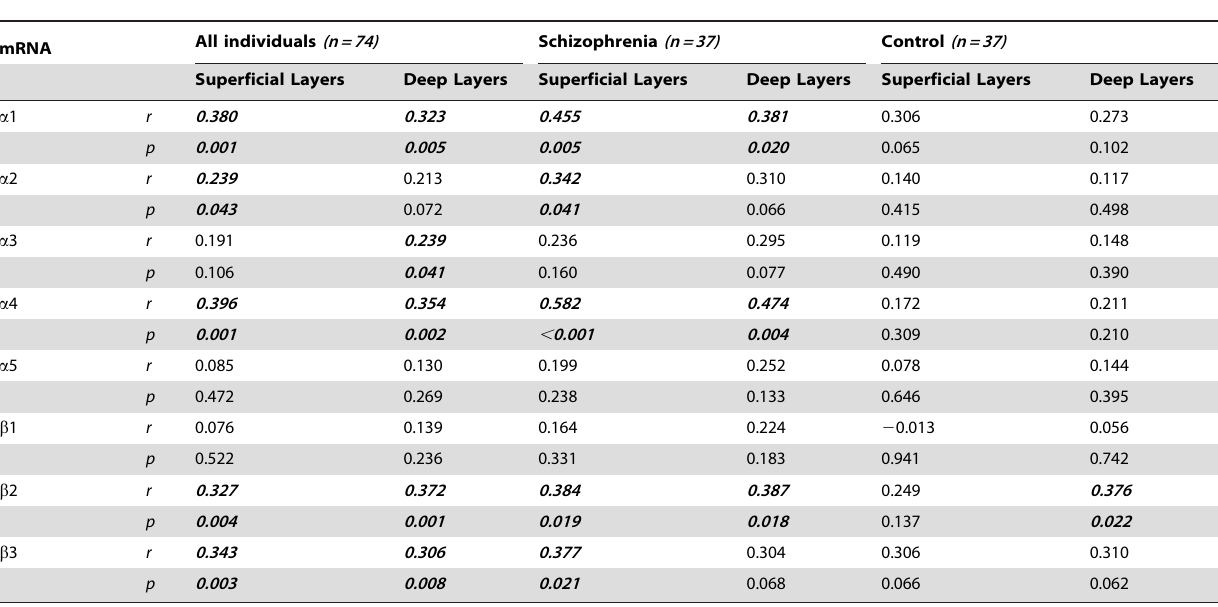
doi:10.1371/journal.pone.0052724.t002